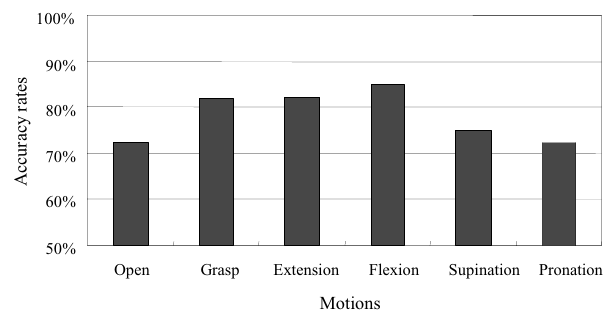
Figure 9 Accuracy rate for continuous motion